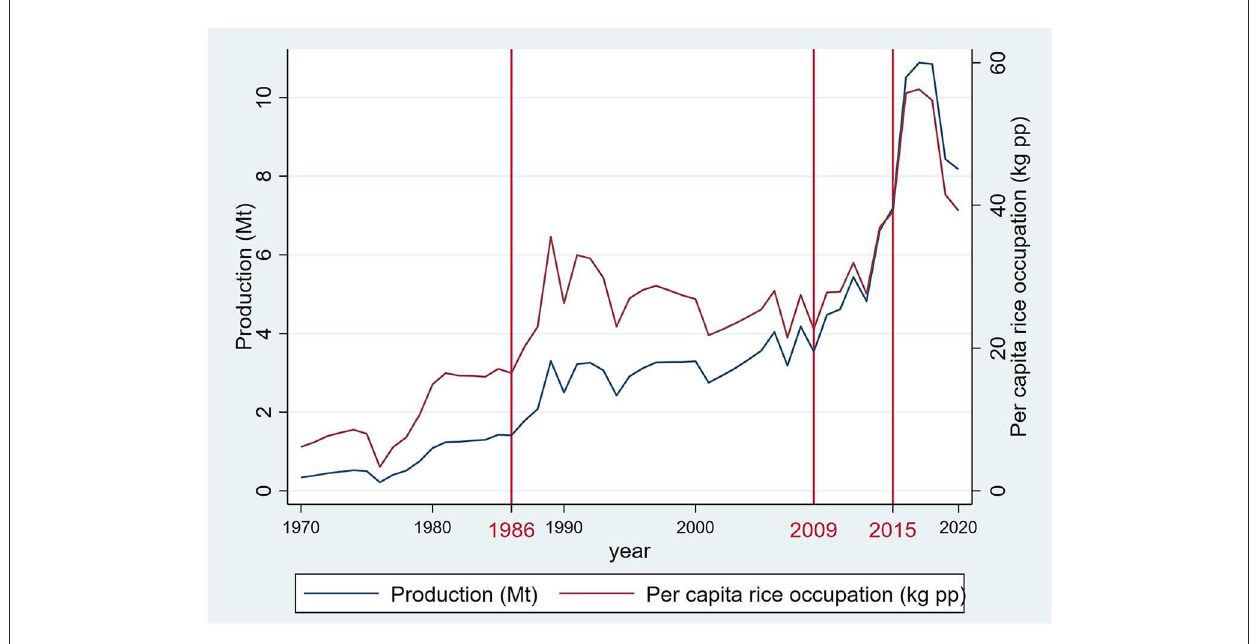
FIGURE2 Rice production and per capita rice occupation in Nigeria from 1970 to 2020. Per capita rice occupation is computed by the authors with data of rice scouring from “Nigeria: Grain and Feed Update” on USDA